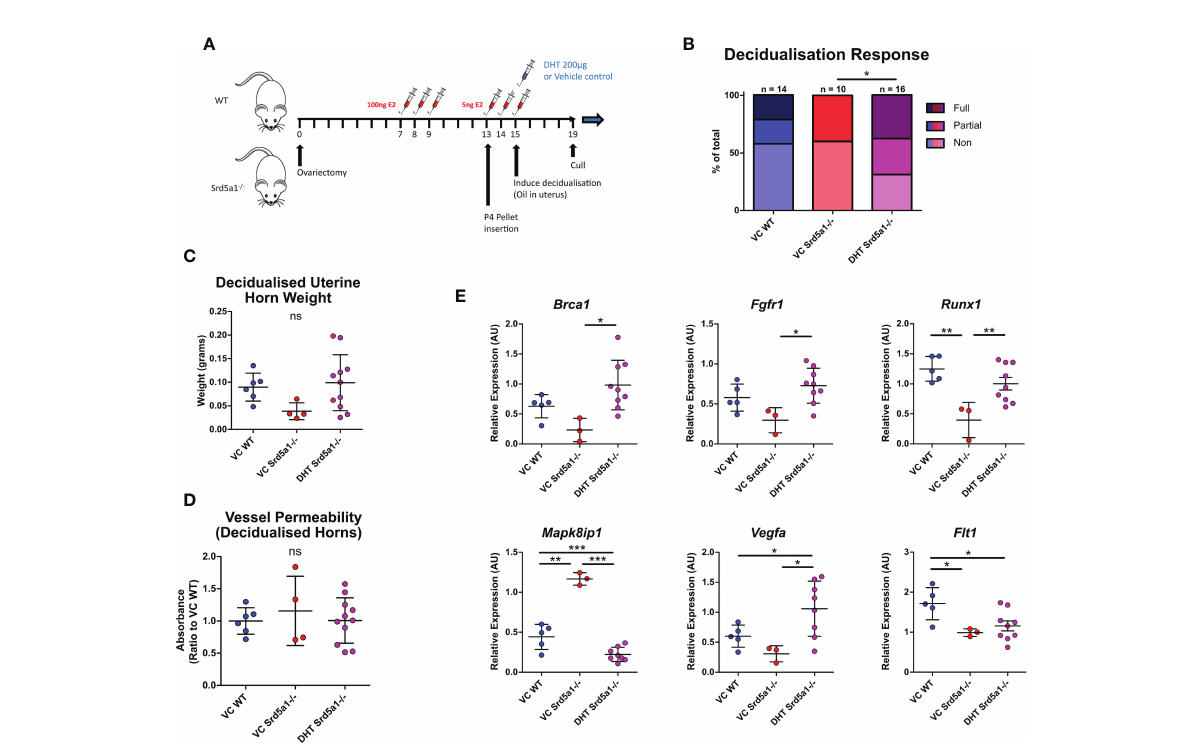
FIGURE 5 Impact of DHT administration on decidualization response in Srd5a1 -/- mice. (A) Schema of decidualization induction experiment in WT and Srd5a1 -/- mice with addition of DHT or vehicle control (VC) at point of decidualization induction. (B) Contingency table depicting proportion of horn responses in WT and Srd5a1 -/- mice treated with DHT or VC. (C) Wet weight of uterine horns. (D) Quanti fi cation of Evans Blue dye absorbance in uterine tissue extracts. (E) Expression of selected genes analyzed by qPCR. Plot in B analyzed by chi-squared test; C,D,E analyzed by one-way ANOVA and Neuman-Keuls post-hoc tests. *p < 0.05; **p < 0.01; ***p < 0.001; ns = no signi fi cant differences